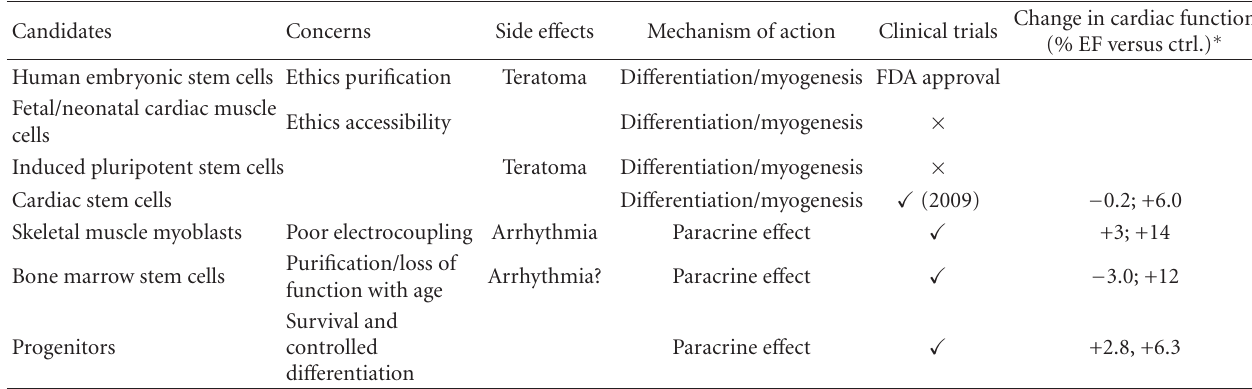
Table 2: Potential cells for new therapeutic